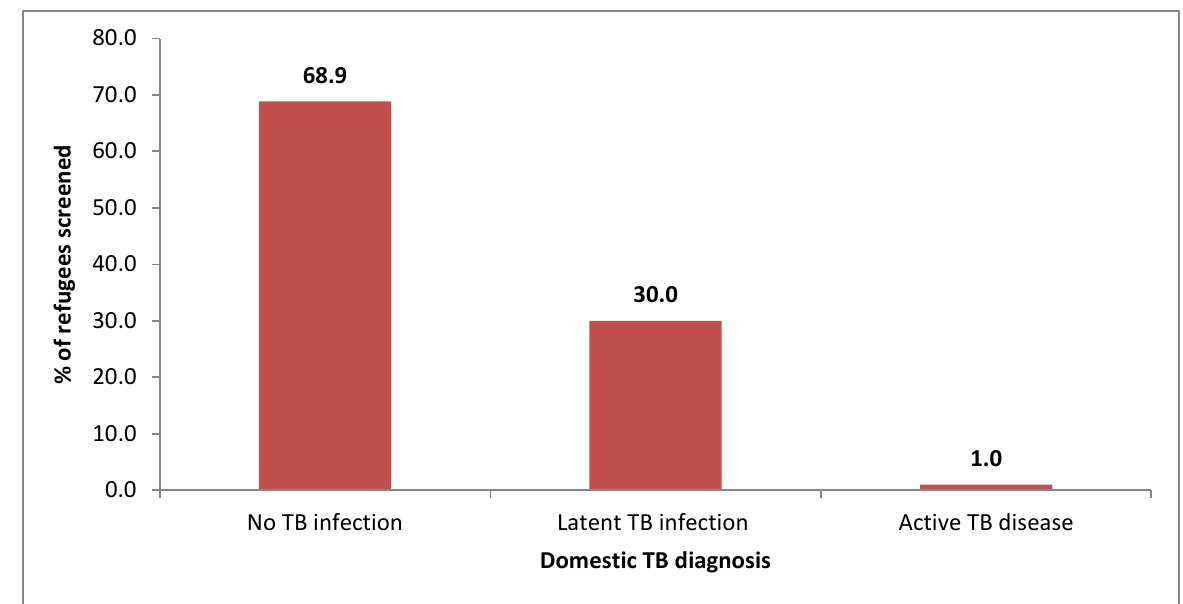
Figure 11: Domestic TB diagnoses of Congolese refugees who were screened for TB in 4 states from 2008 – 2013